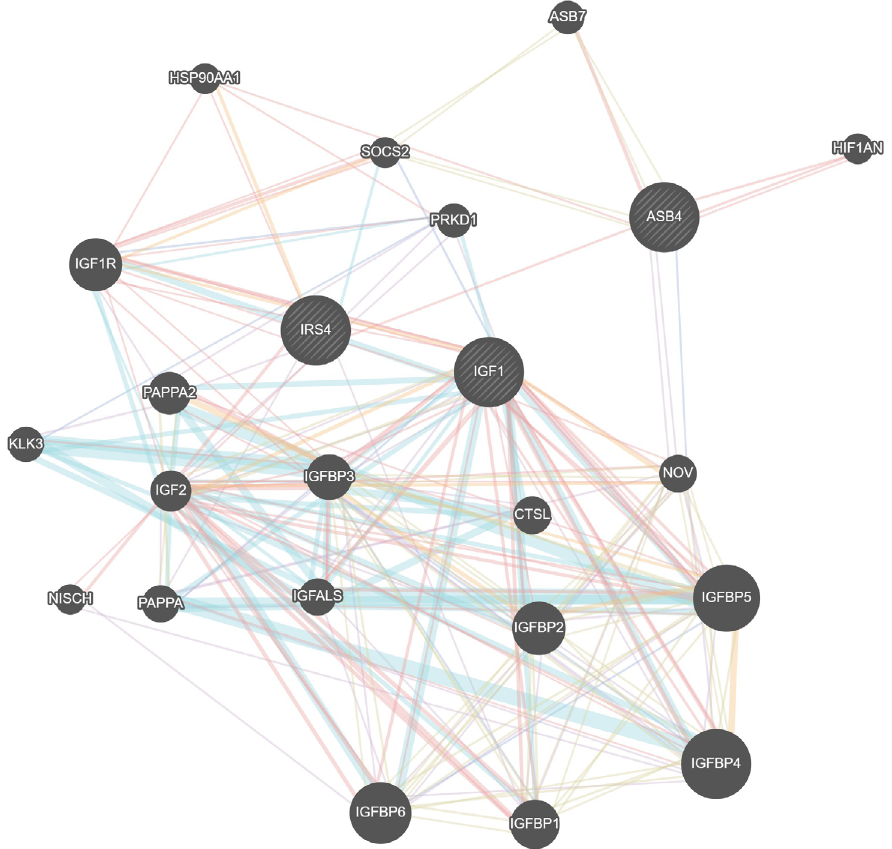
Figure 3. Gene interactions for Class III identifiers. Red represents physical interactions, purple represents co-expression, orange represents predicted interactions, blue represents co-localization, aqua represents a shared pathway, green represents genetic interactions, and yellow represents shared protein domains. Created using